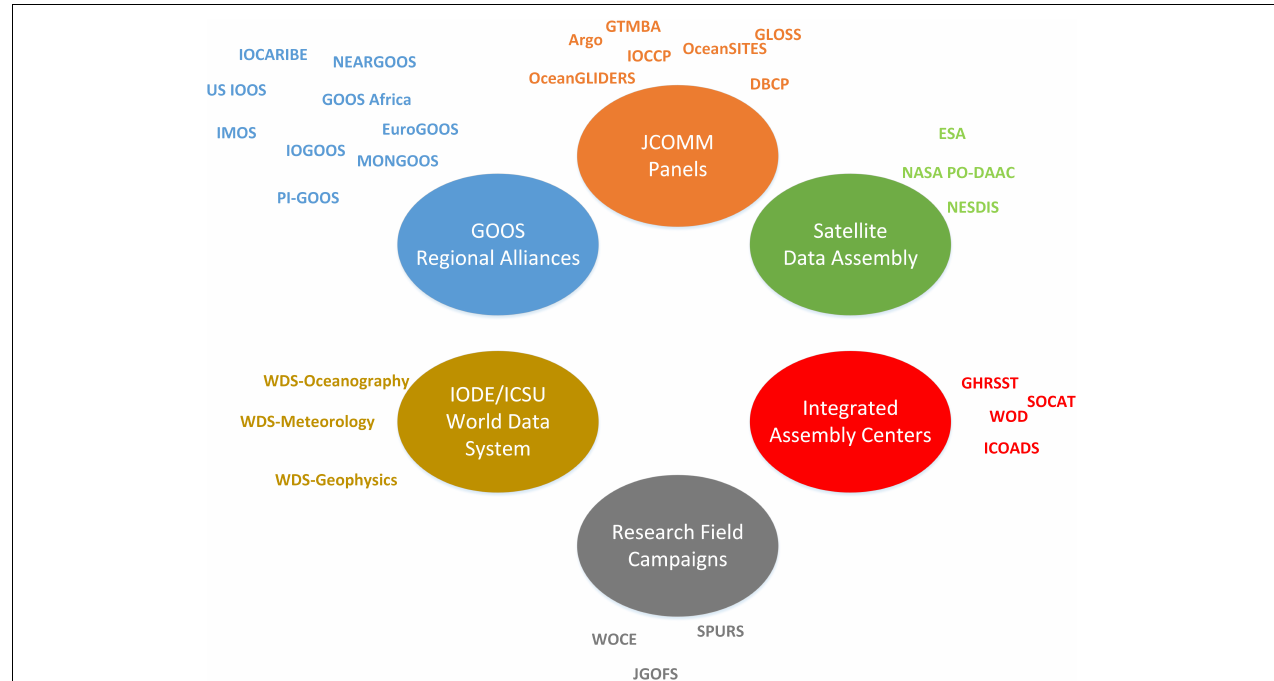
FIGURE 1 | The GOOS Data System comprised of many efforts that are funded and coordinated nationally and internationally. To ensure the successful information sharing between the component systems is enhanced through (i) data interoperability standards and protocols for measurements, data exchange and data management, (ii) ensure effective and efficient linkage among elements (measurements, data management and communications, data analysis), (iii) formulate rules of engagement for establishing the operational elements of the global